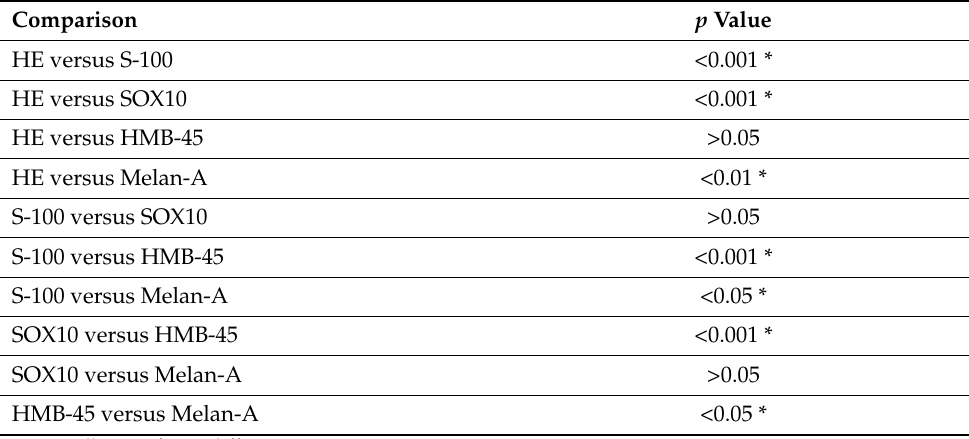
Table 4. Results of the post hoc analysis based on Dunn’s multiple comparison test.